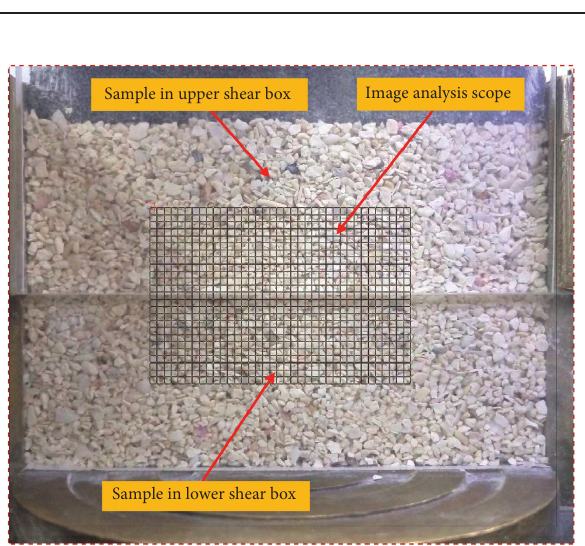
Figure 4: Image analysis area.